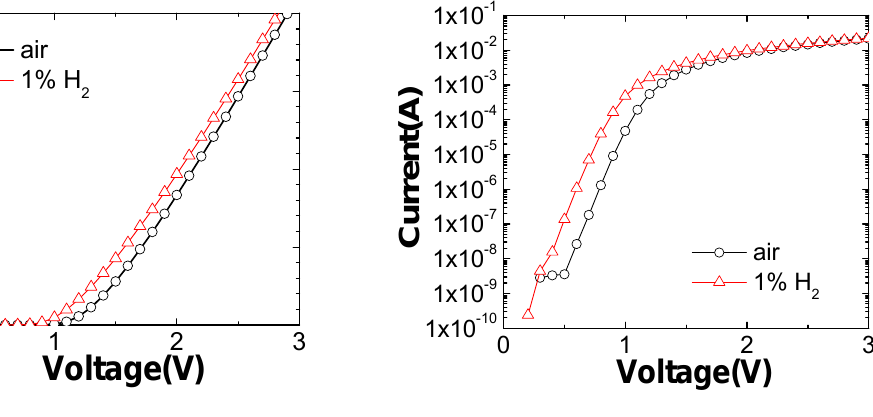
Figure 9. I-V characteristics in linear (top) or log (bottom) form of Pt-gated diode measured in air or 1% hydrogen ambient at 25